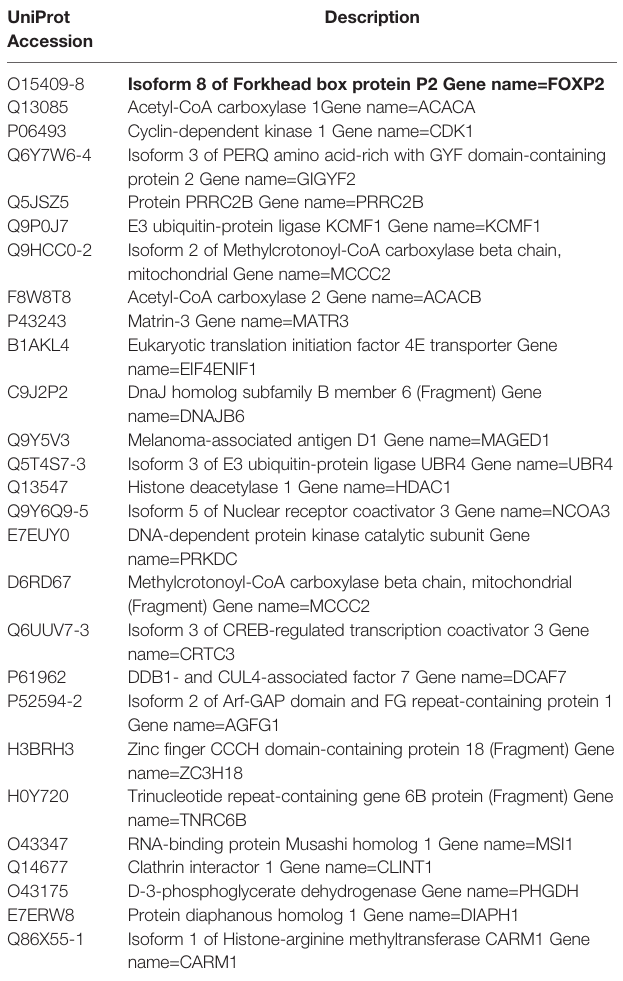
TABLE 1 | List of candidate FOXA2-interacting proteins from the mass spectrometry screens. UniProt Accession